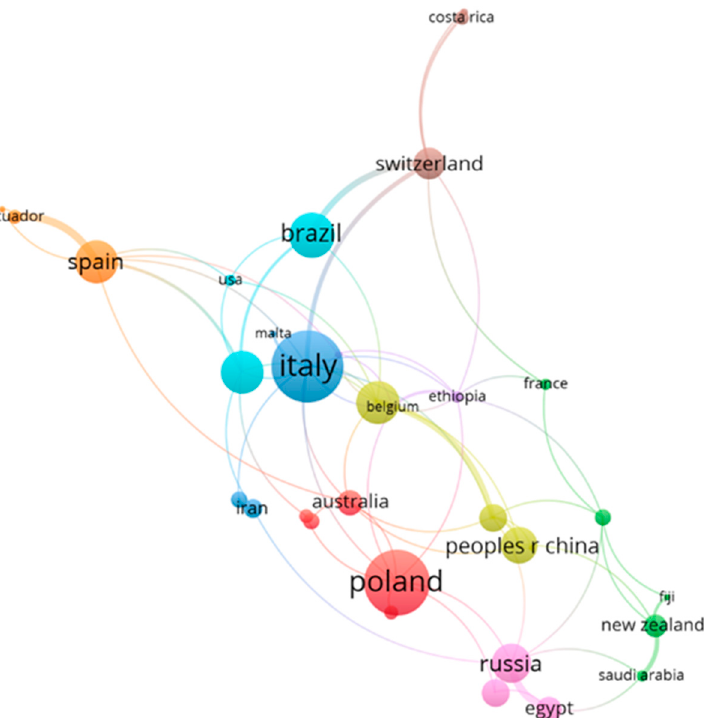
Figure 3. Network visualization in the VOSviewer program. The size of the circle and label are proportional to the frequency in number of studies per country of correspondence. The intensity of the lines shows the strength of the association between co-citations and the colors show the groups of co-citations among authors of each country.